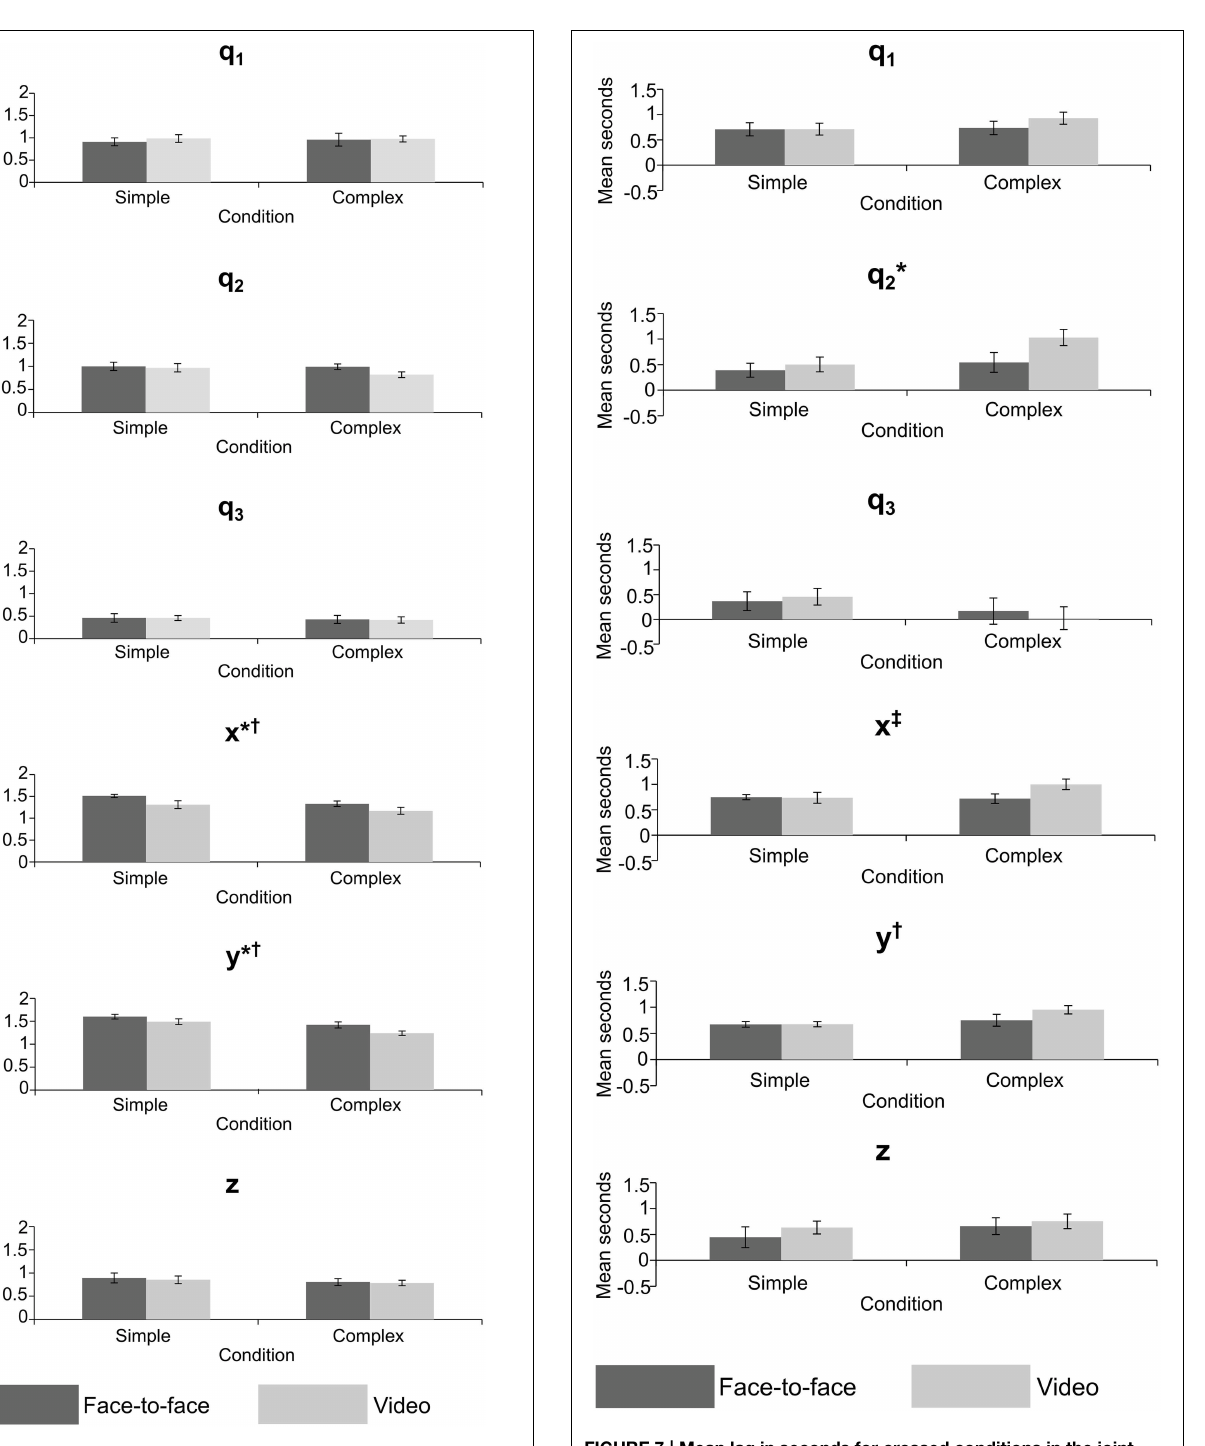
FIGURE 6 | Mean Z -value for crossed conditions in the joint angle and grip position variables, error bars = standard error; * significant effect of feedback, † significant effect of task difficulty. p < 0 . 05 for all significant effects—see Table 1 for exact values.